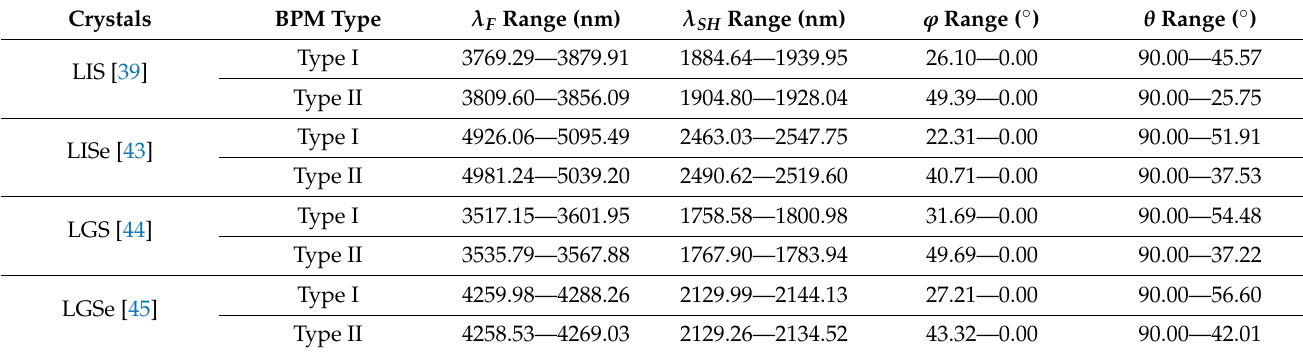
Figure 7. Numerical simulation results of BPM and GV matching in biaxial orthorhombic ternary chalcogenides: ( a ) Type I and ( b ) Type II in LIS; ( c ) Type I and ( d ) Type II in LISe; ( e ) Type I and ( f ) Type II in LGS; and ( g ) Type I and ( h ) Type II in LGSe. Table 7. Broadband SHG conditions of mid-IR biaxial crystals: the ranges of λ F and λ SH , and the corresponding range of the F-wave vector direction ( θ and ϕ